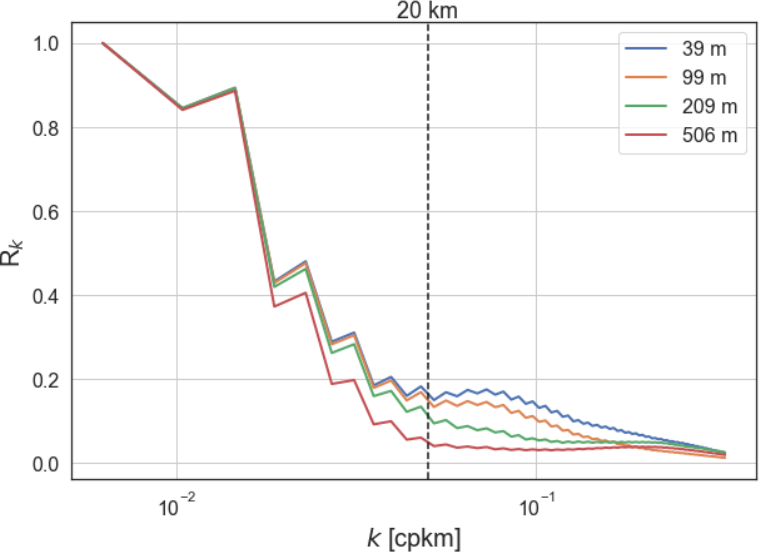
Figure 7. Ratio R k of the strain rate explained by eddies of size k and the strain rate explained by larger eddies. The “effective” strain rate is captured by wavelengths larger than 20